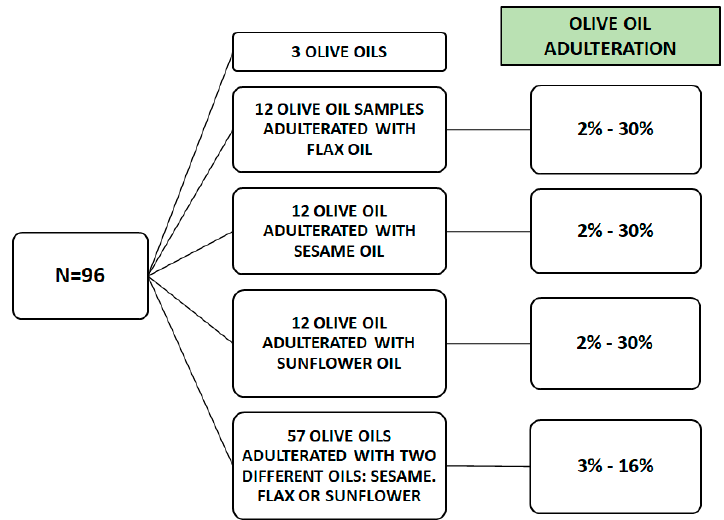
Figure 1. Sample preparation scheme (N = 96). Three pure olive oils, 12 samples of olive oil (4 samples of extra virgin olive oil, 4 samples of virgin olive oil and 4 samples of olive oil) adulterated with flax oil, 12 samples of olive oil adulterated with sesame oil, 12 samples of olive oil adulterated with sunflower oil, and 57 samples of olive oil adulterated with two of the selected adulterant oils. Table 1. Percentage distribution of binary (olive oil and one adulterant oil) and ternary (olive oil and two adulterant oils)